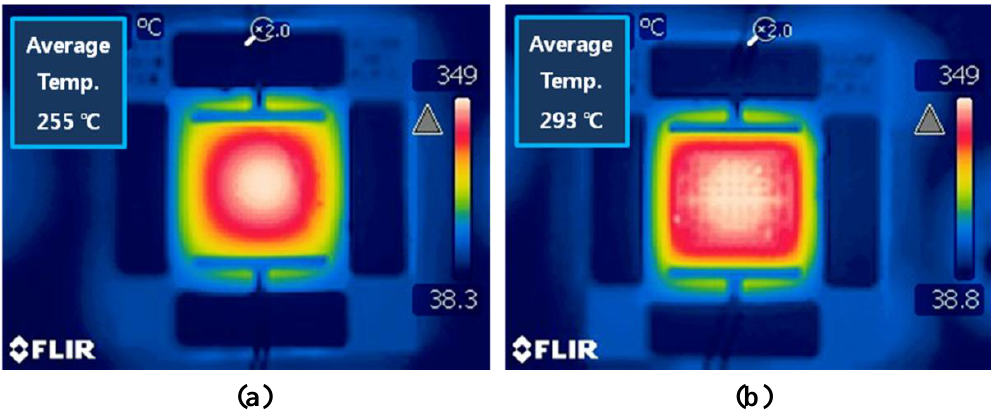
Figure 6. Measured average temperature of micro-heaters at 350  C as maximum temperature.